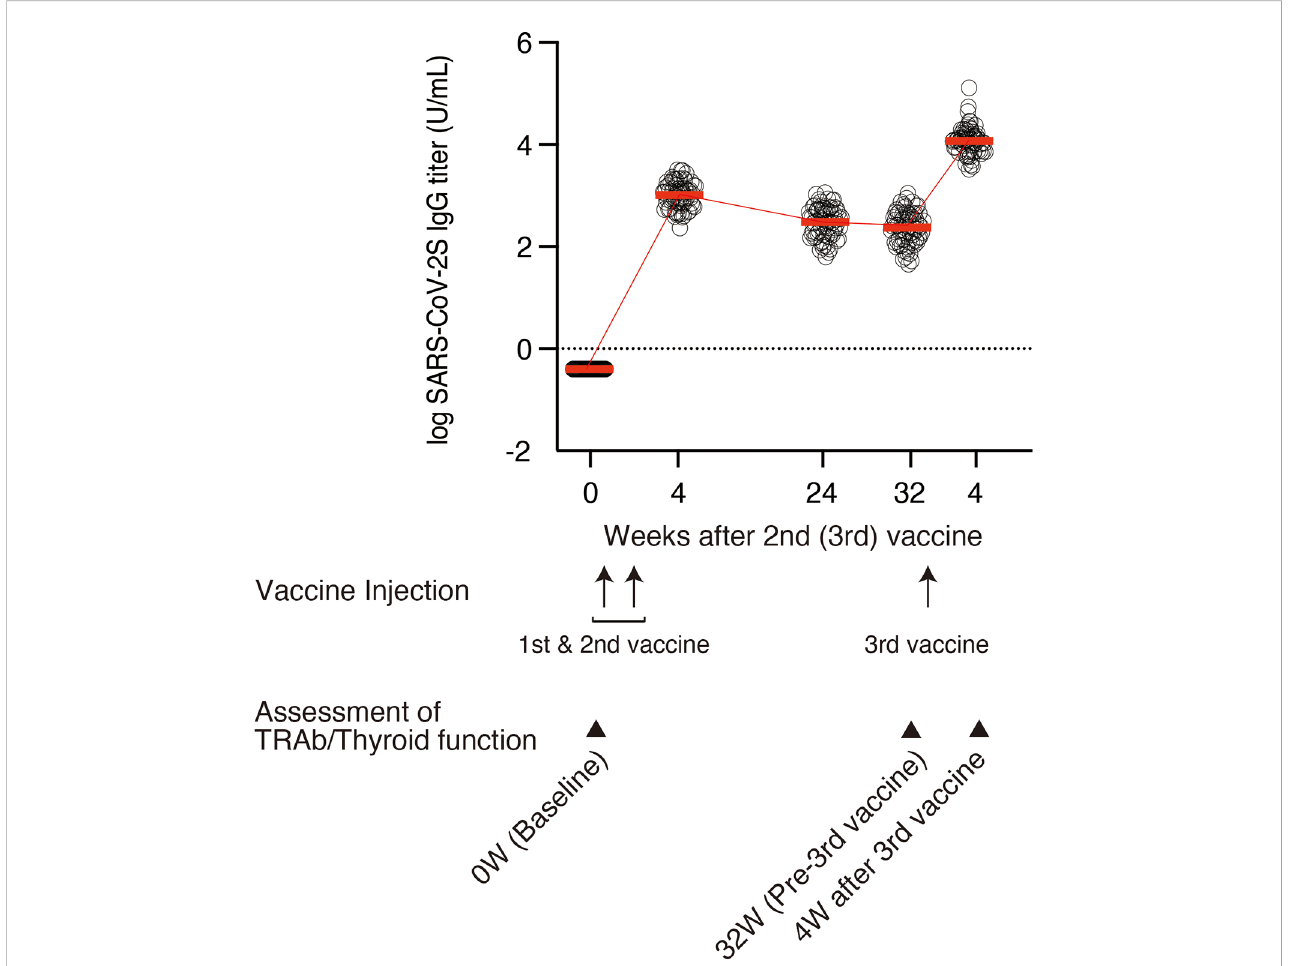
FIGURE 1 Timelines and trends of logarithmically transformed anti-SARS-CoV-2 S IgG titers at 0 (baseline), 4, 24, and 32 weeks after the second dose of vaccine and 4 weeks after the third dose of vaccine (n = 70). Each circle denotes individual log IgG titers. Mean values of anti-SARS-CoV-2 S IgG titer are indicated by red bars. Mean values are also presented in Table 1. TRAb and thyroid function were analyzed at 0 (baseline), 32 weeks after the second dose, and 4 weeks after the third dose of vaccine. TgAb and TPOAb were also assessed at 32 weeks after the second dose and 4 weeks after the third dose of vaccine in 33